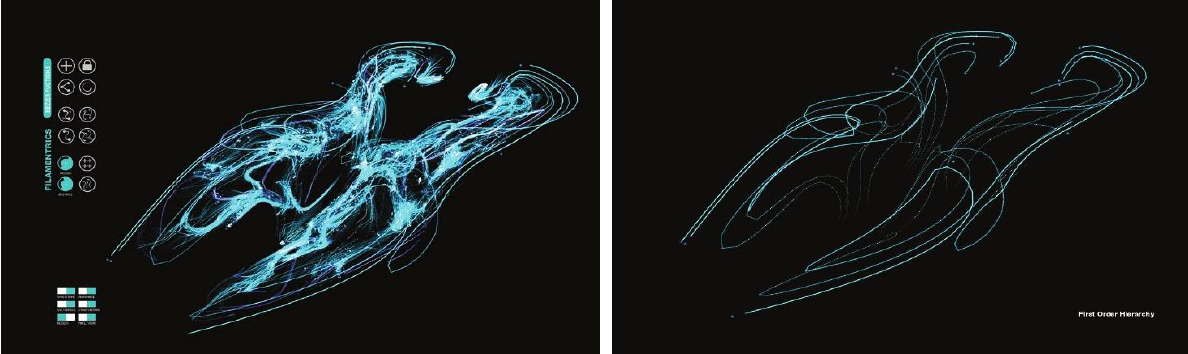
Figure 10. Initially, the first hierarchy of the design system is generated by agents that flow the vector field while affect one another with behaviours of cohesion, separation and alignment.